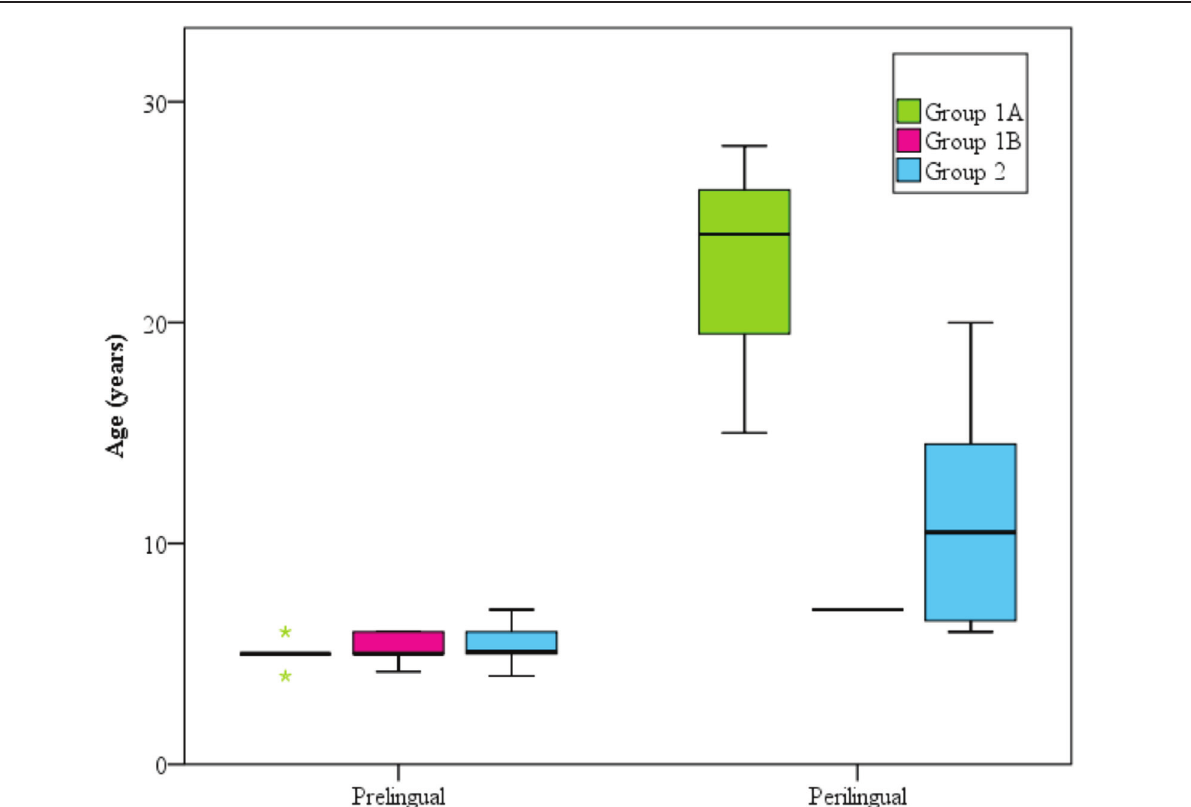
Comparison among the three studied groups according to